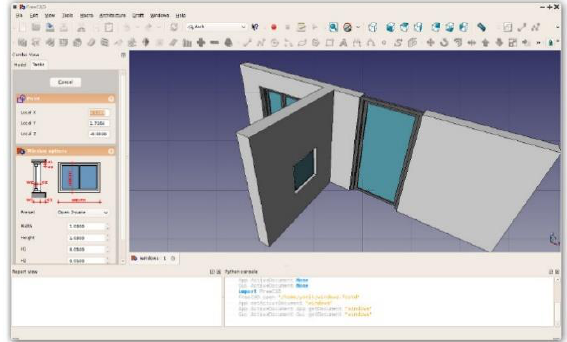
Figure 6. Creating with Arch Module, (FreeCADweb, 2016)